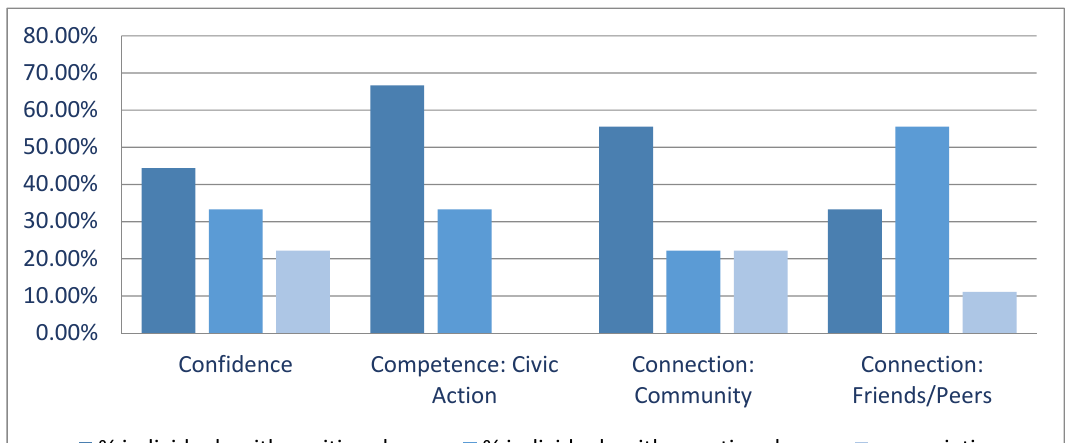
Figure 1: Percent of Participants with Variation in Pre/Post PYD